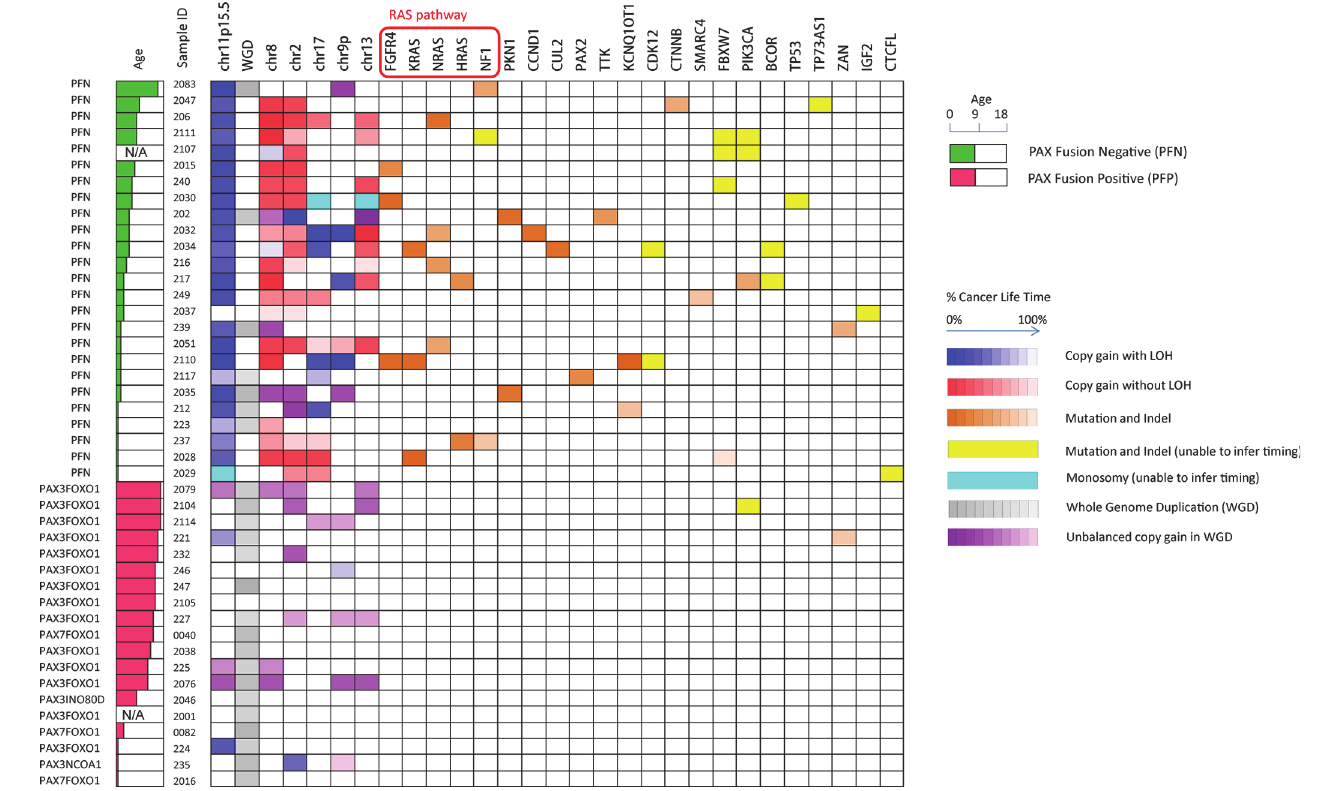
Fig 4. Summary of recurrent somatic lesions found across the 44 tumors and the estimates of their occurrence time. The heatmap denotes the occurrence of the lesions and their timing (the brightness of grids represents the percentage of cancer lifetime when the lesion occurred). The occurrence time of a mutation is represented as the median of its inferred time interval. Note that within a single chromosome, there may be multiple segments with different copy number status, and we only show the arm-level copy number alterations in this figure. 11p15.5 LOH with copy gain and the mutations in RAS pathway are consistently early events during the development of PFN